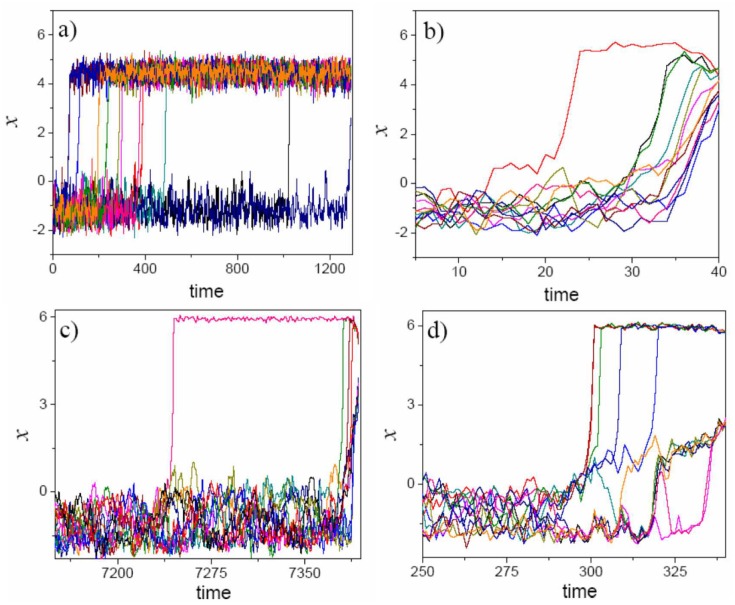
One realization of Eq (1) for different values of α.
(a):
α = 0, (b):
α = 0.15, (c):
α = 0.7, (d):
α = 1.